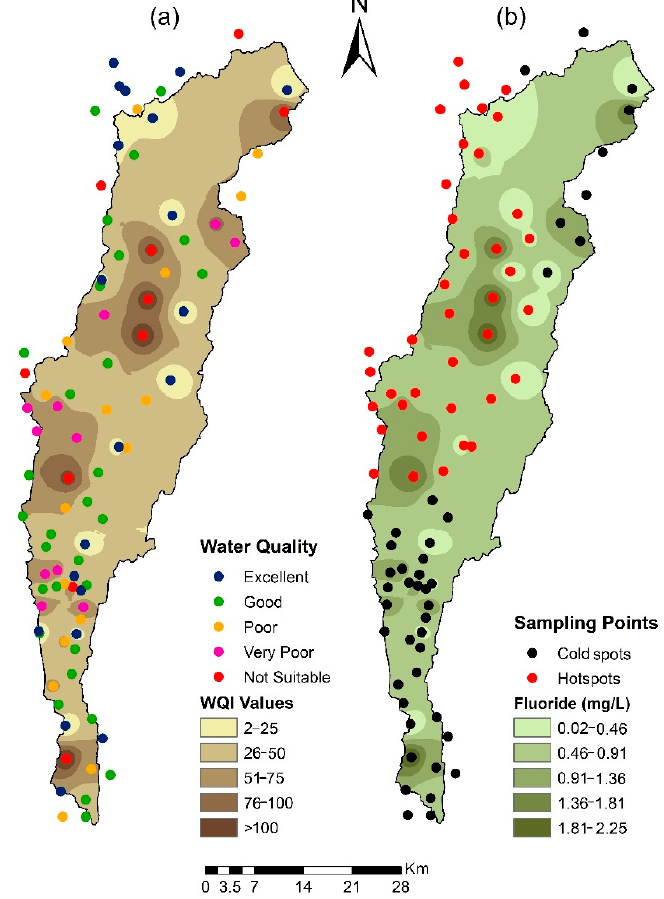
Figure 6. Spatial distribution of ( a ) WQI and ( b ) fluoride concentration of groundwater samples in Yan Oya Basin, Sri Lanka.